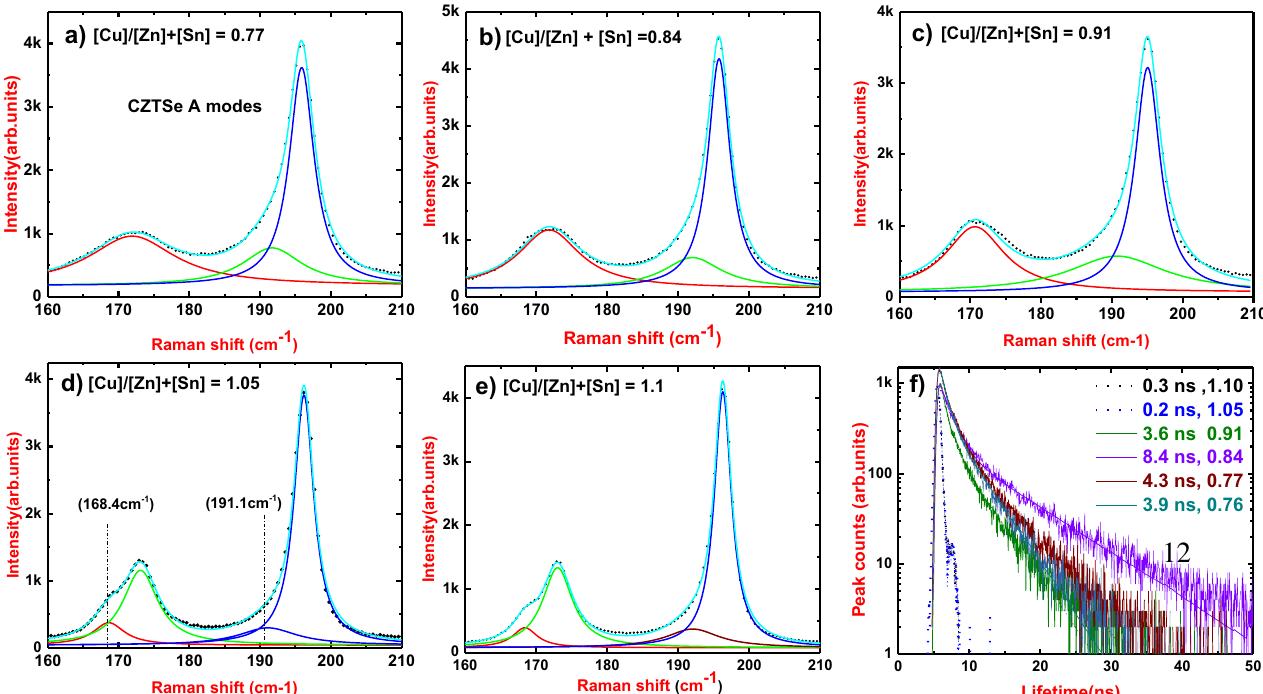
Fig. 3. (a)–(c) Detailed peak fitting of Kesterite A modes of Cu poor CZTSe thin film absorber (d) and (e) Detailed peak fitting of Kesterite A modes of Cu rich CZTSe thin film absorber. (f) Comparison of the minority carrier lifetimes of Cu poor and Cu rich samples in this